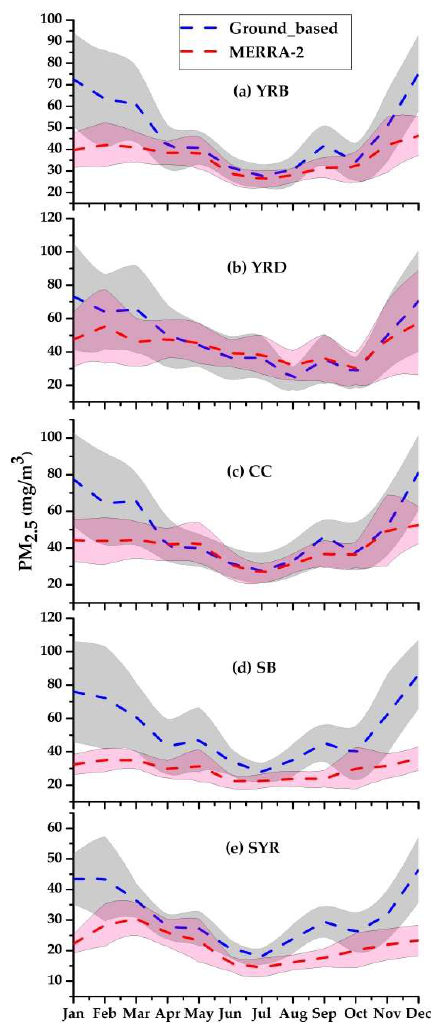
Figure 3. Monthly variations in PM 2.5 concentrations derived from MERRA-2 (red dashed lines) reanalysis and ground sites (blue dashed lines) over the ( a ) YRB, ( b ) YRD, ( c ) CC, ( d ) SB and ( e ) SYR for the period of Jan. 2015–Dec. 2016. The shading represents the standard deviation of MERRA-2 (red) and ground-based PM 2.5 (gray).